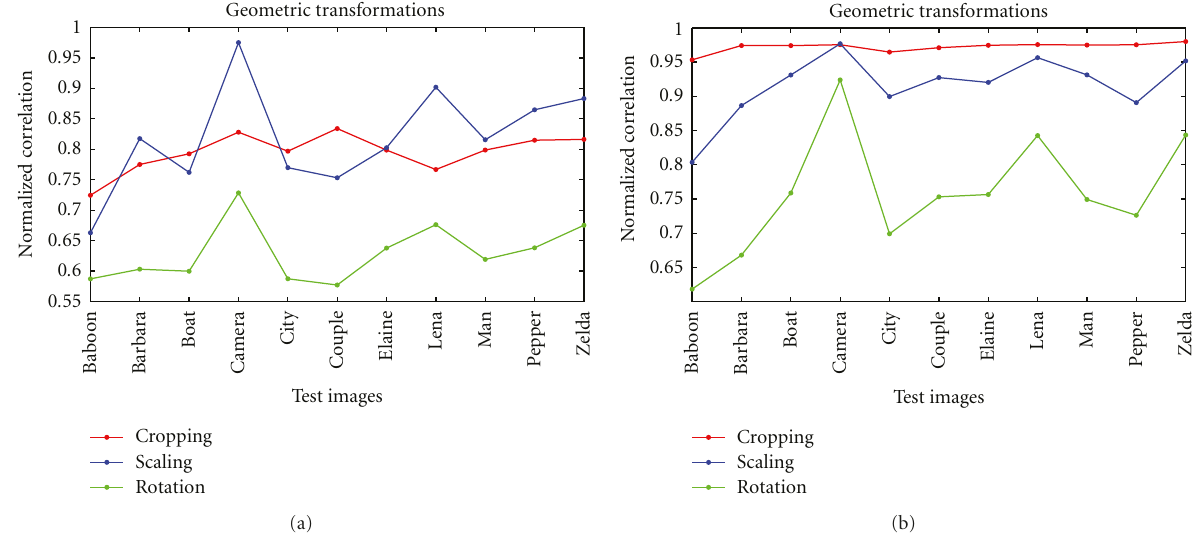
Figure 15: Normalized correlation results of di ff erent test images under geometrical attacks: (a) embedding in the highest frequency subband of the host image (b) embedding the watermark in the 16th directional subband.